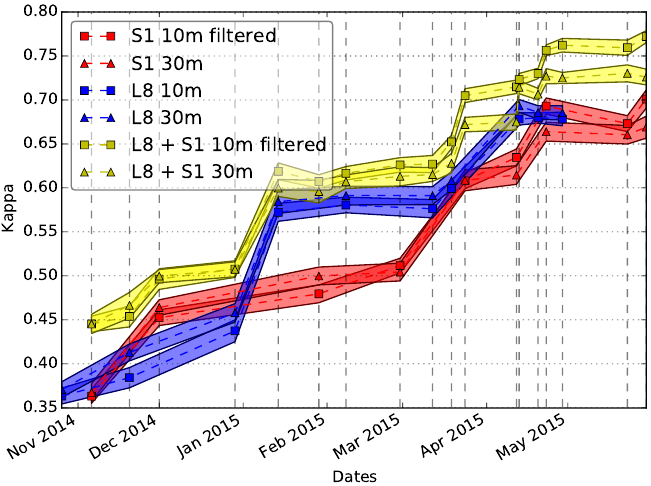
Figure 8. Comparison of classification accuracy with data resampled to 10 m with speckle filtering and data at 30 m without speckle